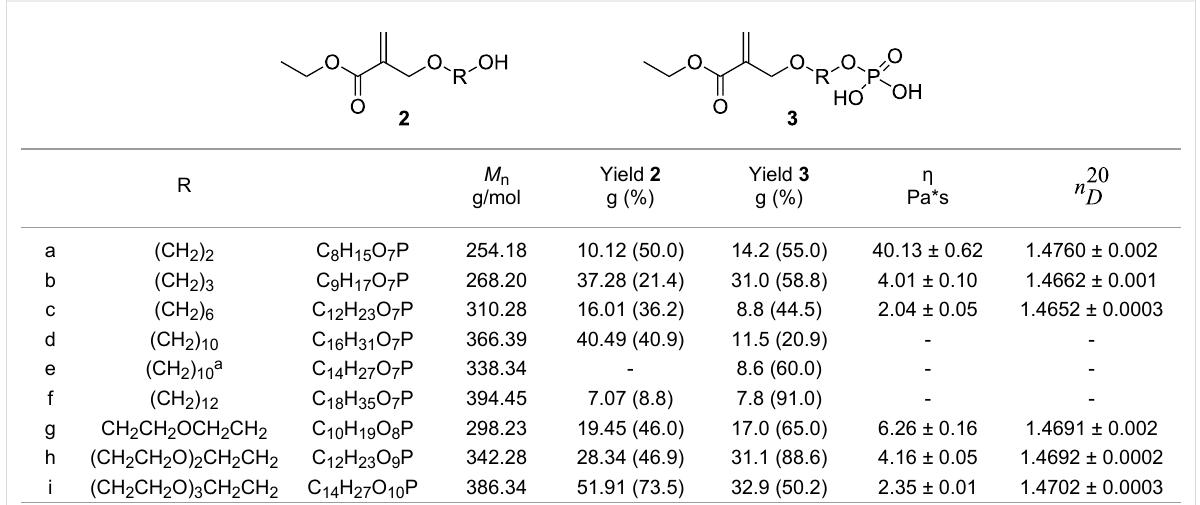
Table 1: Yields, viscosities and refraction indexes of molecules 2a–2i and 3a–3i